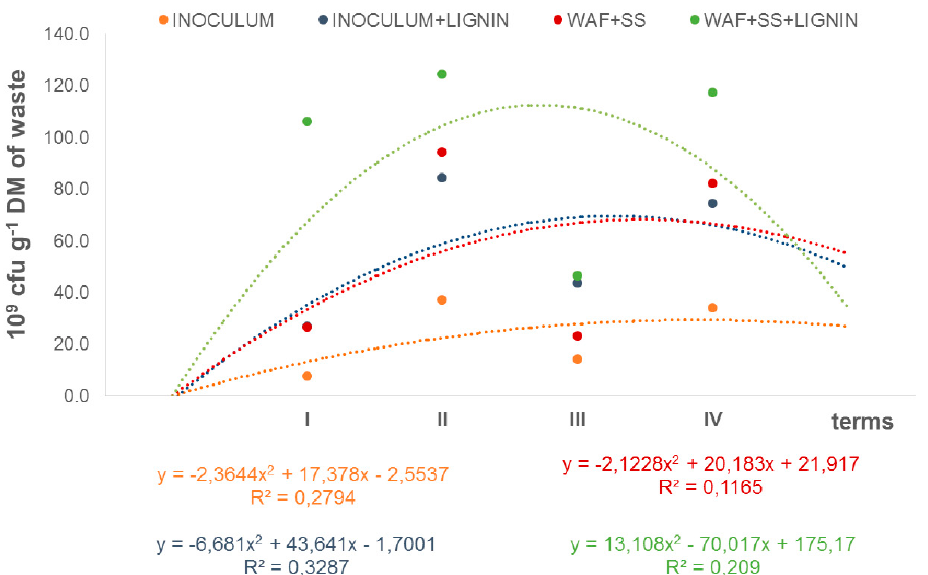
Figure 8. Variation in the total count of heterotrophic eubacteria in the samples subjected to anaerobic digestion.